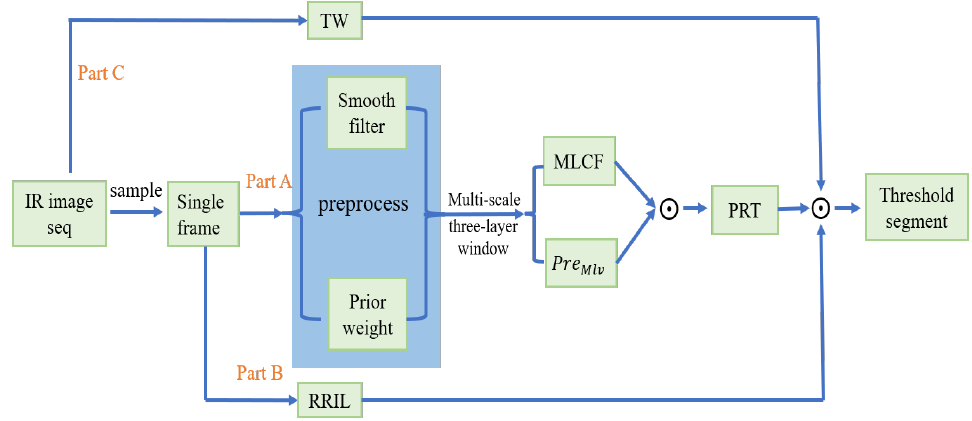
Figure 2. Flowchart of the proposed